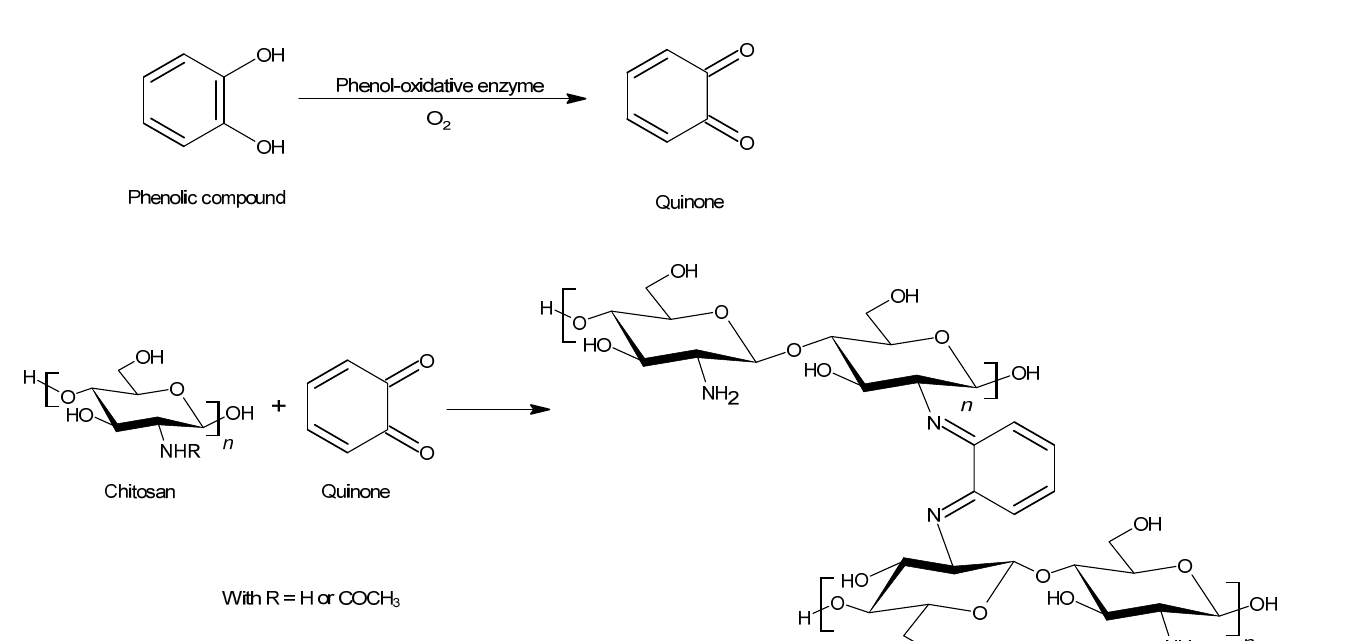
Figure 4. Covalent cross-linking reaction between chitosan and a phenolic compound (pyrocatechol).